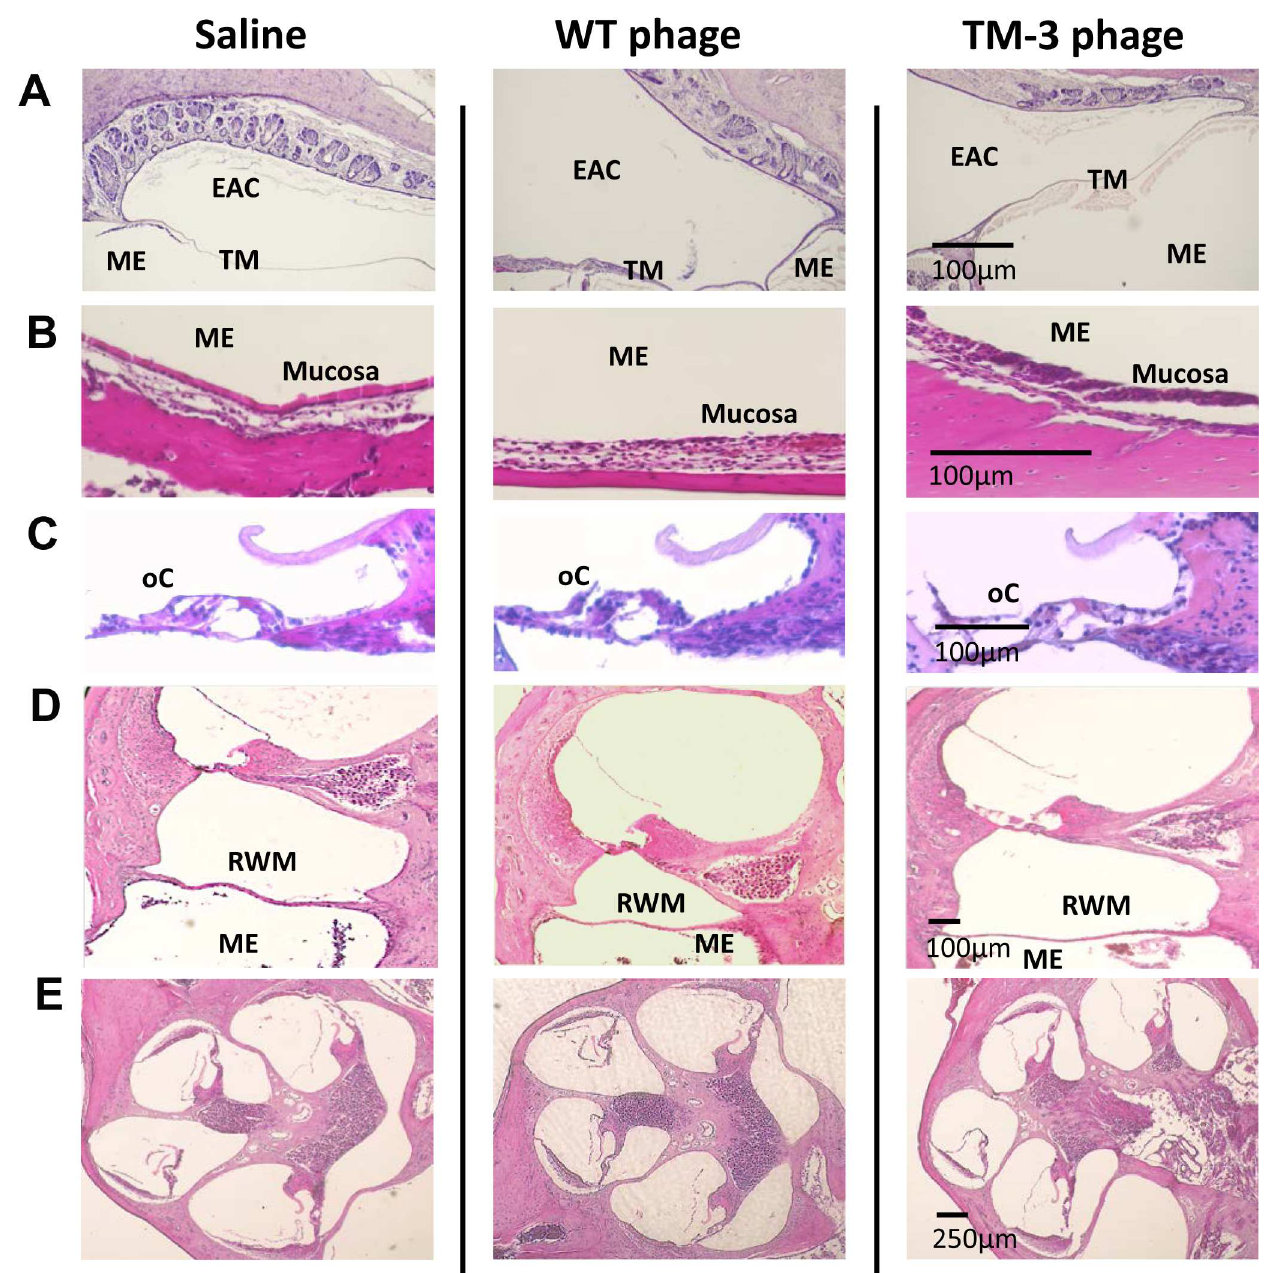
Fig 5. Histological evaluation of the ear after trans-TM peptide phage application, compared to WT phage negative control and saline control. A. Hematoxylin and eosin (H&E) stainedsections illustrate the external auditory canal (EAC), TM and ME, 24 hrs after applicationof 10 10 TM-3 phage or controls to the external surface of the TM. B-E. The ME and ME mucosa ( B ); the organ of Corti (C); the ME, RWM and cochlear basal turn ( D ) and the cochlea( E ), 24 hrs after applicationof 10 10 TM-3 phage directly into the ME.